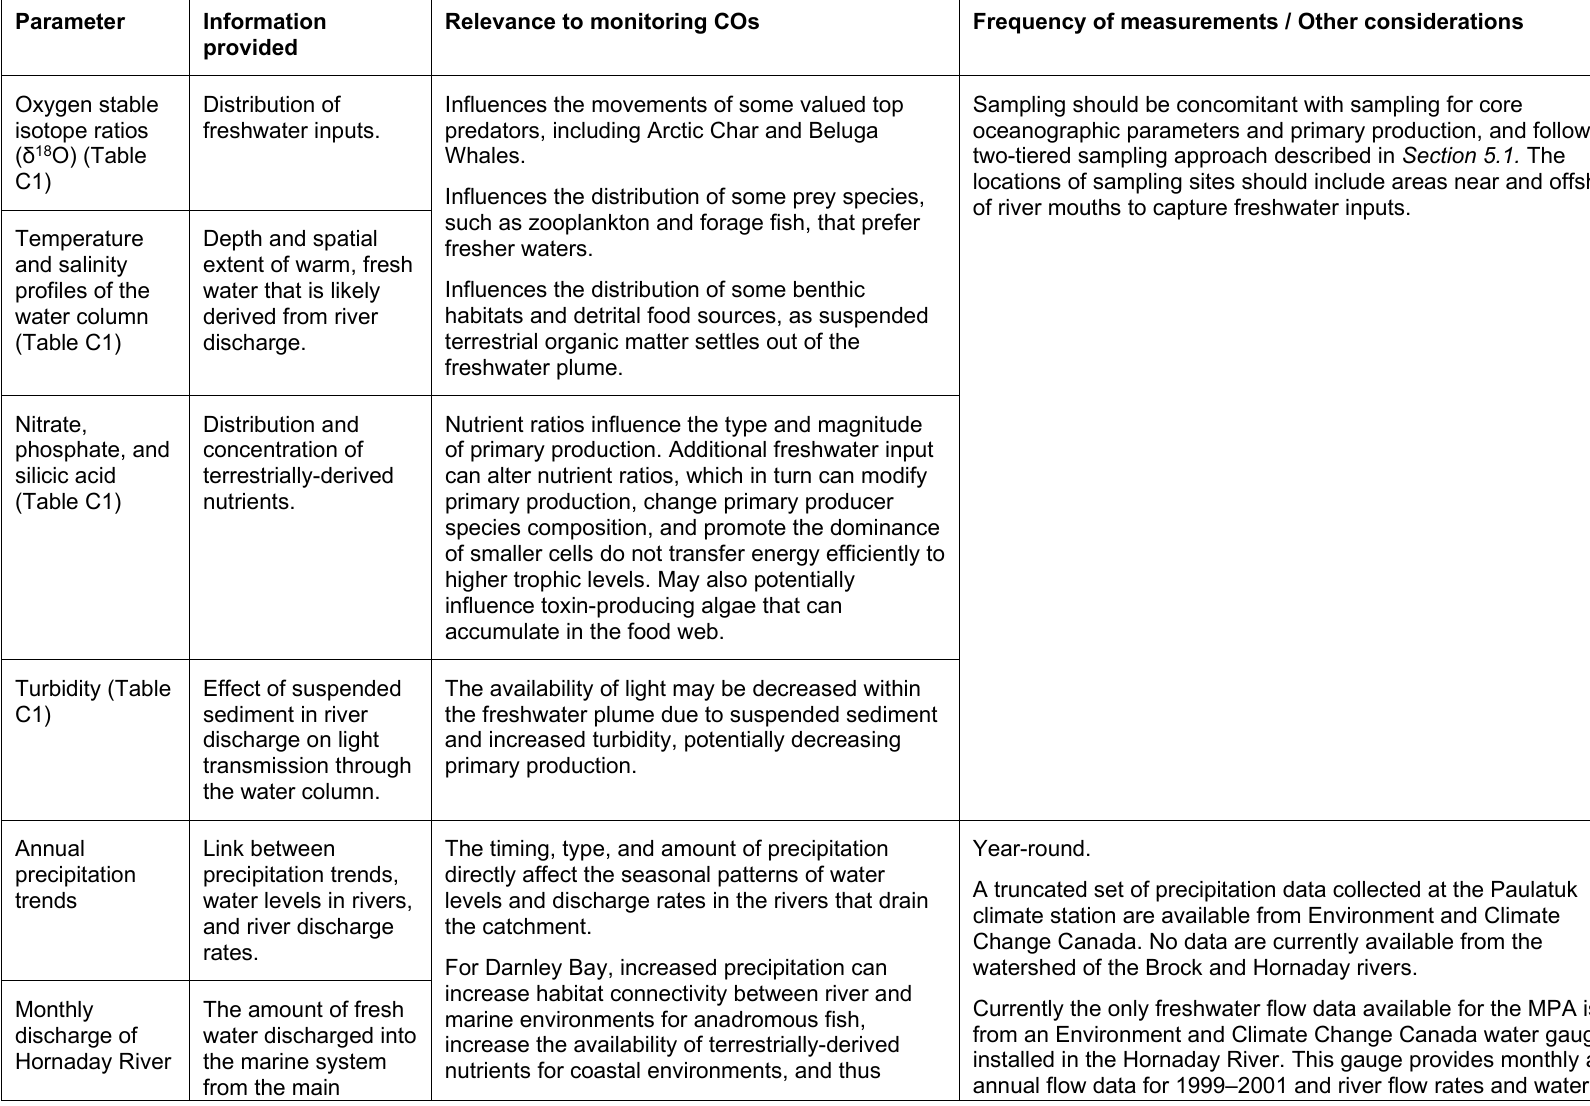
Table C5. Key measurement parameters for monitoring freshwater inputs and terrestrial linkages (Section